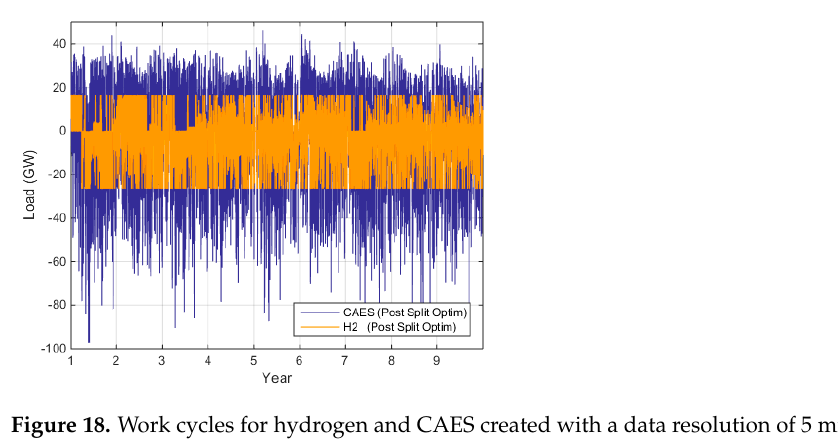
Table 4. Comparison between work cycles created for X = 0.5 based on data with a resolution of 1 h and 5 min.